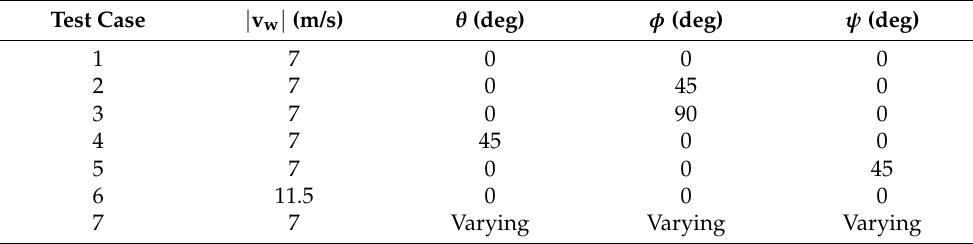
Table 5. The test cases and parameter